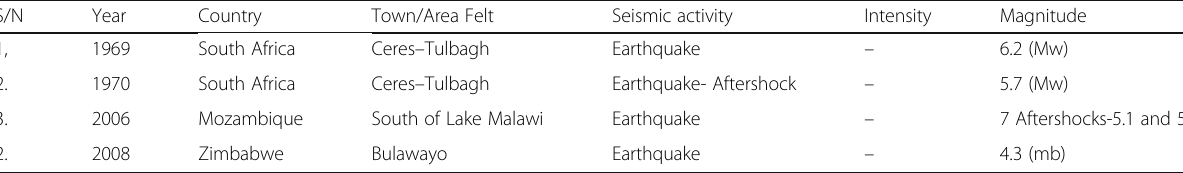
Table 5 Seismic occurrences, location, year, magnitude and intensity in Southern Africa